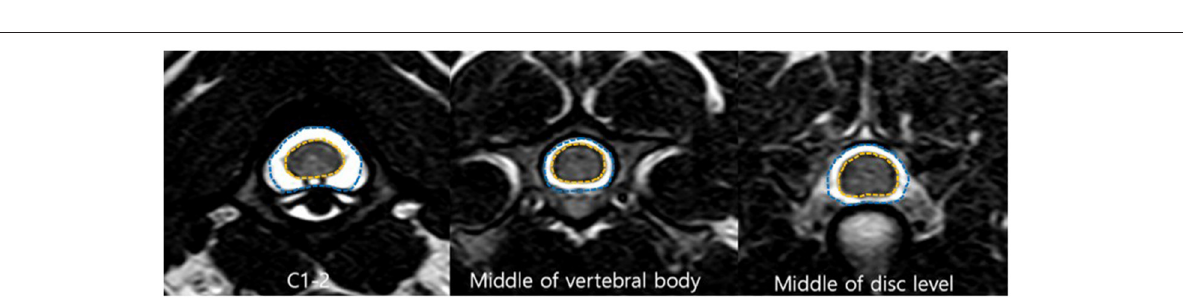
(nine), and Beagles (two). Eleven dogs were male and nine were female. The mean age was 3.60 years (range, 1.6–8.0 years)